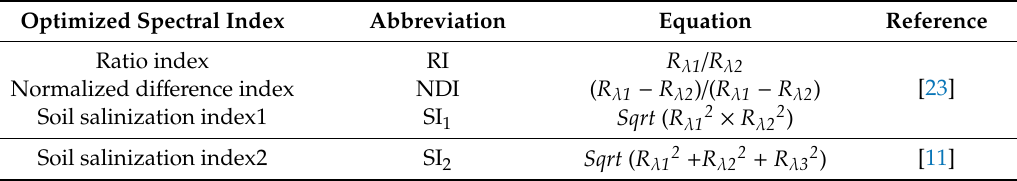
Table 2. Optimized spectral indices selected in this